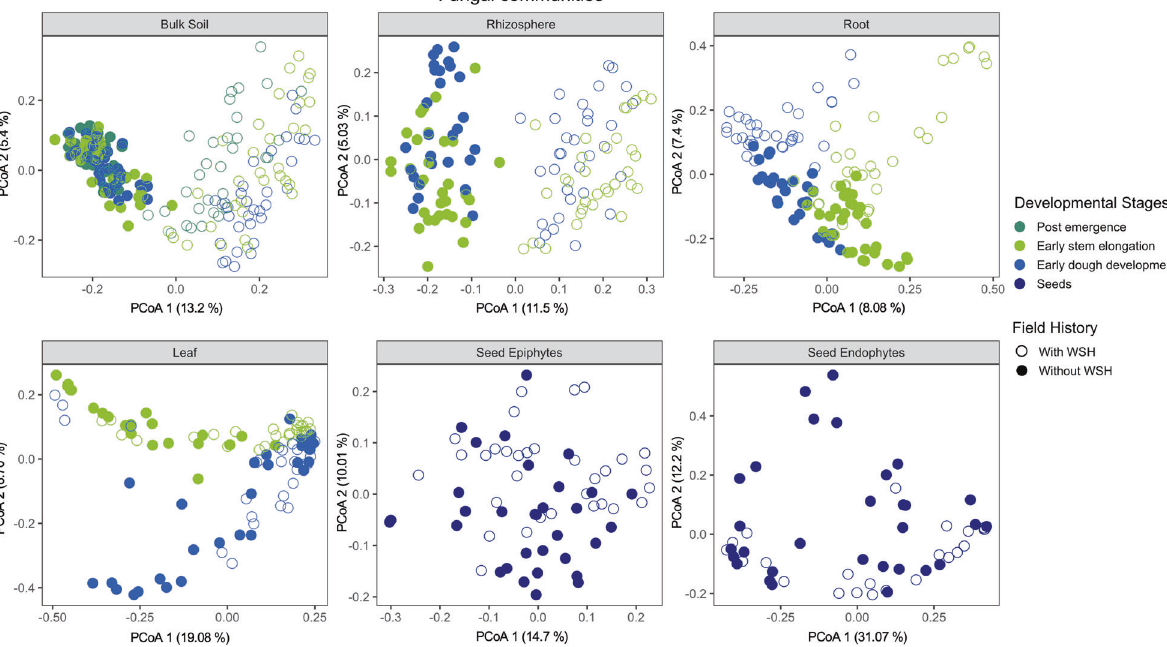
Fig. 3 Changes in fungal community structure. Principal coordinate analyses (PCoA) of Bray – Curtis dissimilarity to evaluate how dissimilar the bulk soil, rhizosphere, leaf, root, seed epiphytes and endophytes associated fungal communities were with respect to the experimental factors including irrigation, fi eld history, developmental stages, genotype and their